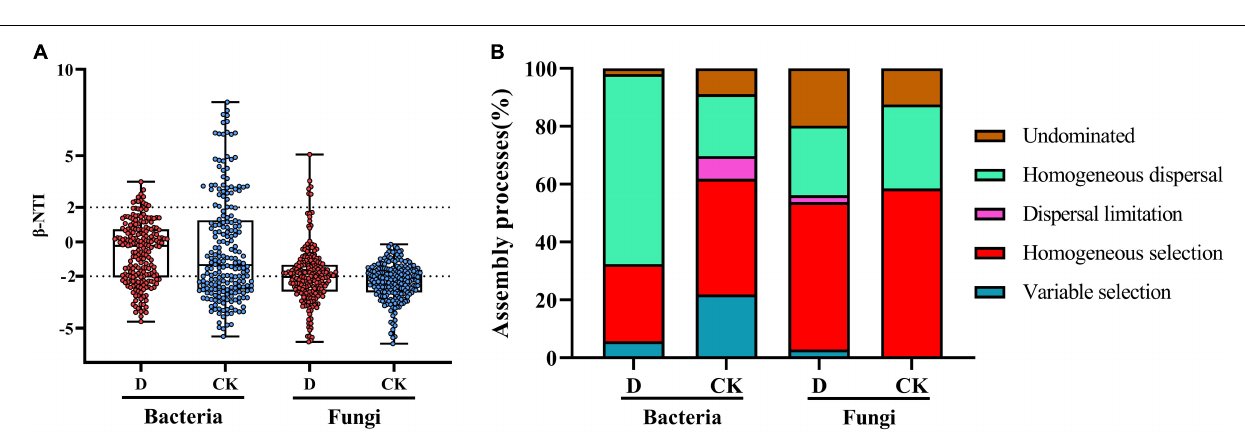
FIGURE 7 | The microbial community assembly processes in the cropping obstacle soil (D) and in the healthy control soil (CK). (A) The values of the weighted beta nearest taxon index ( β NTI). Horizontal dashed gray lines indicate upper and lower significance thresholds at β NTI = − 2 and + 2, respectively. (B) The percentages of deterministic processes (homogeneous and variable selection), stochastic processes (dispersal limitation and homogeneous dispersal), and undominated